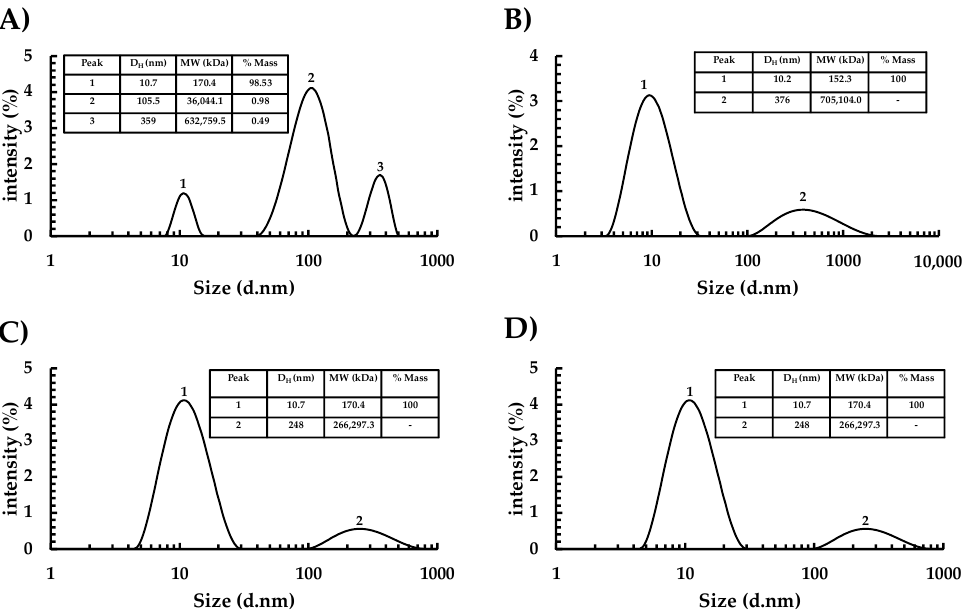
Figure 3. DLS intensity size distribution of Ah11Sn at different pH values. ( A ) pH 3, ( B ) pH 6, ( C ) pH 7, ( D ) pH 8. D H and d correspond to hydrodynamic diameter, MW: calculated molecular weight in kDa.